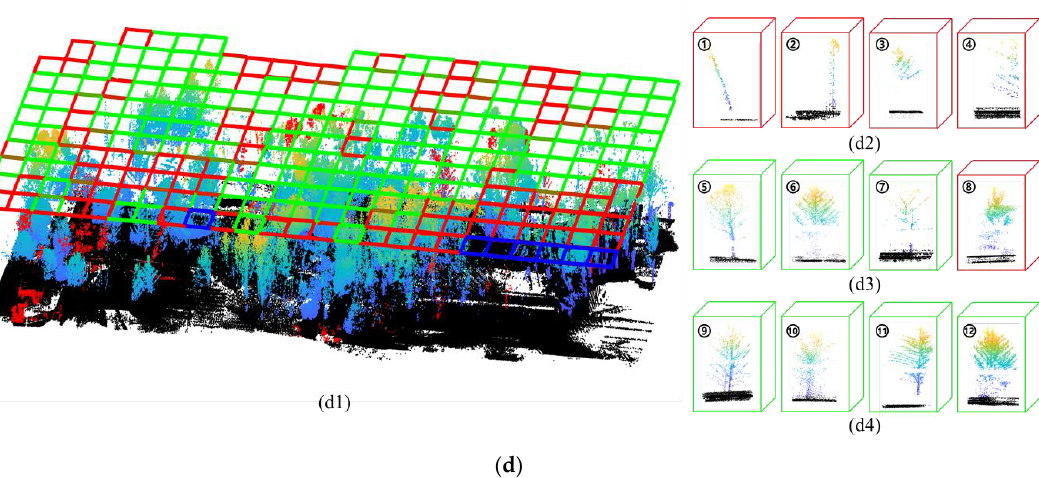
Figure 7. Recognition results of the partial LiDAR data belonging to the four forest plot types in our study sites using PointNet model: ( a ) nursery base, ( b ) monastery garden, ( c ) mixed forest, and ( d ) defoliated forest. A simplified representation using the upper rectangles in different colours represents the classification results of the point clouds below within each corresponding voxel, where the green, blue and red rectangles in ( a1 , b1 , c1 , d1 ) indicate that the point clouds under the rectangle within the voxel were recognized as trees, buildings and other objects, respectively. ( a2 , a3 , a4 , b2 , b3 , b4 , c2 , c3 , c4 , d2 , d3 , d4 ) show the zoomed classification results for the point clouds in some voxels.